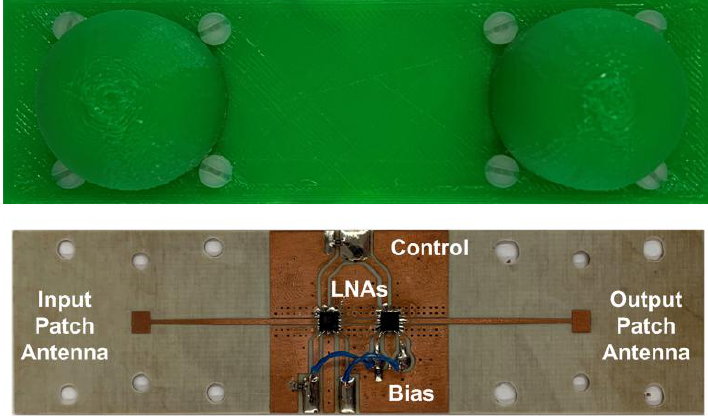
Figure 10. Photo of the prototype.